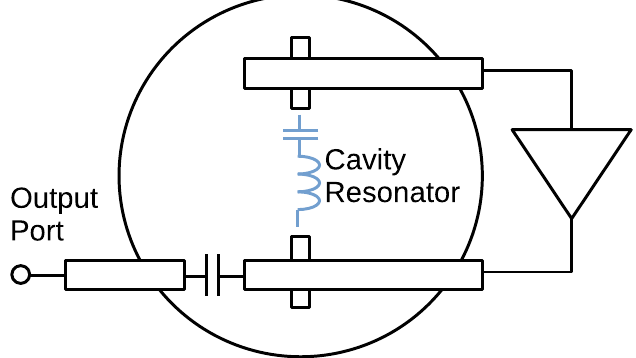
Figure 10. Oscillator circuit used for the sensor.